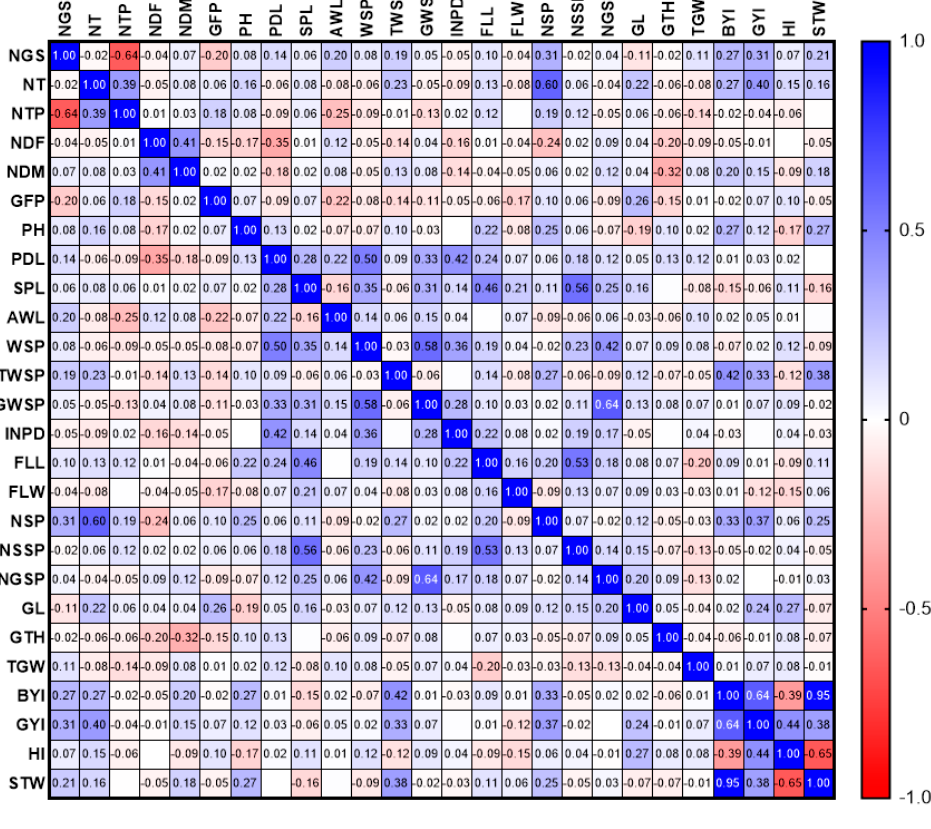
Figure 8. Correlation of study traits in F8 wheat lines resulting from Gonbad × Kohdasht in 2021. The results of stepwise regression showed that, when GYI is considered as a dependent variable and other traits as independent traits, GYI is explained by NSP and INDP (Table 5). However, NT and NGS and GL in 2020 best explained GYI (Table 6). Table 5. Results of stepwise regression of grain yield per hectare as a dependent variable and other traits as the independent variables in the F8 population resulting from Gonbad × Kohdasht cross in 2020. Traits